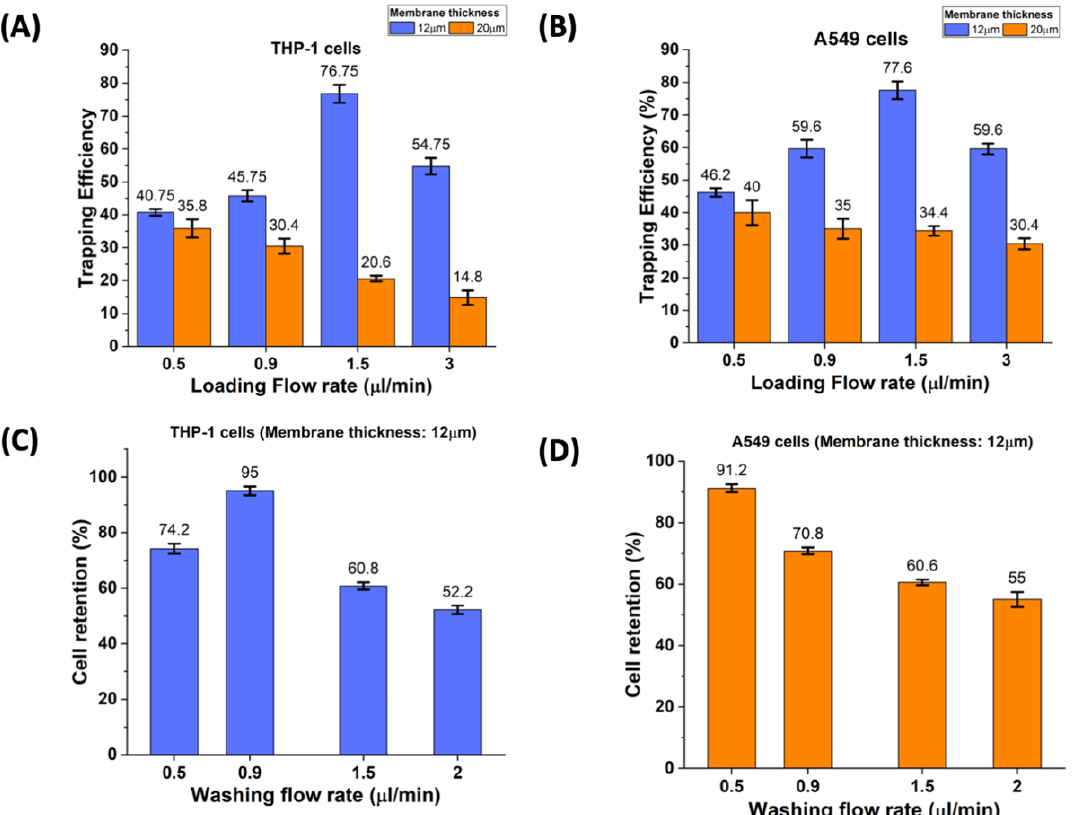
Figure 6. Factors responsible for THP-1 and A549 cell trapping. ( A ) Effect of cell loading flow rate on the THP-1 trapping efficiency. ( B ) Effect of cell loading flow rate on the A549 trapping efficiency ( C , D ) Effect of washing flow rate on cell retention of THP-1 and A549. An efficiency of 95% and 91% were achieved for THP-1 cells and A549 cells, respectively. Error bars, mean ± s.d., ( n = 3) ( p < 0.05). This optimization step was carried out on non-fluorescence labelled